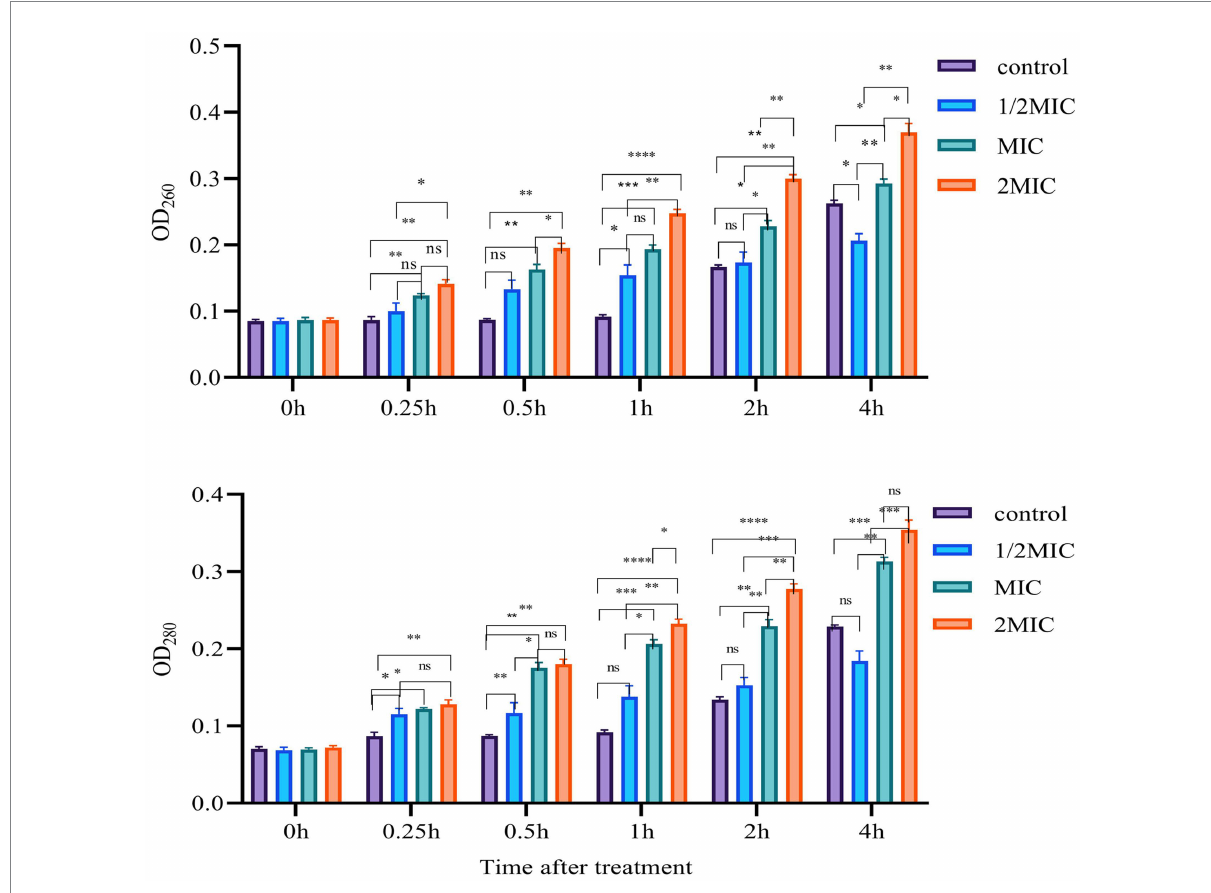
FIGURE 7 Cell membrane leakage results. Error bars represent standard deviation from the mean of three replicate values (ns non statistically significant difference, * p <0.05, ** p <0.01, *** p <0.001, **** p